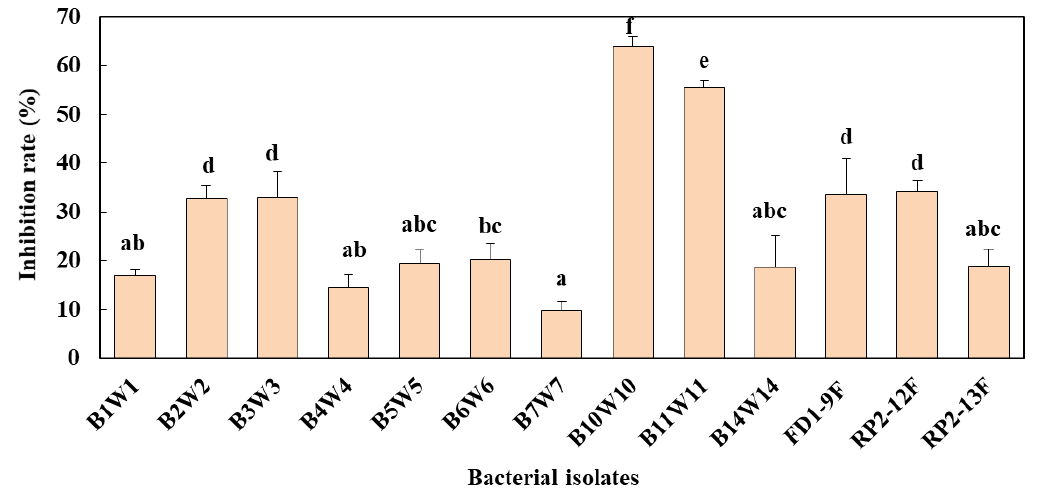
Figure 4. Inhibition rates of spore germination of M. fructigena obtained with cell-free bacterial filtrates (at 100% concentration) after 24 h post-incubation at ambient temperature. Treatments having the same letter are not significantly different according to the LSD test ( p < 0.05).